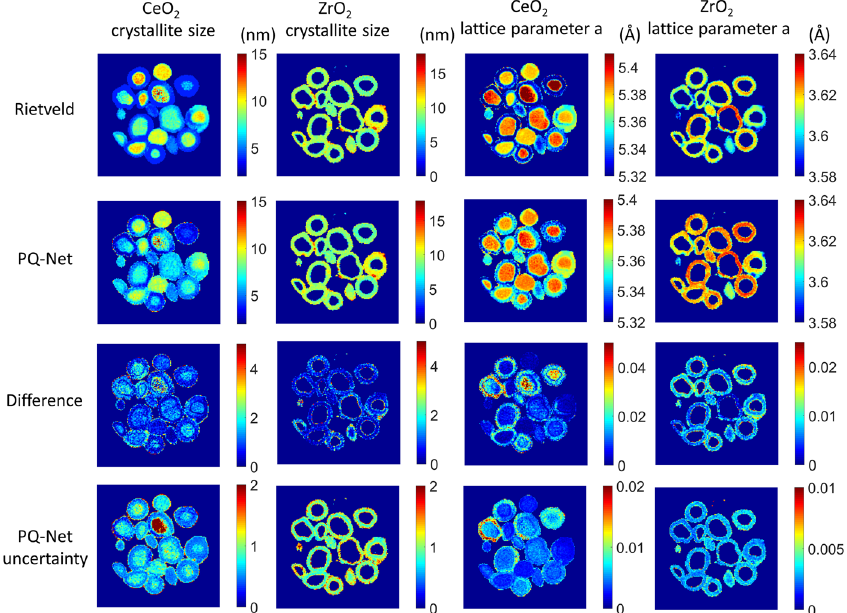
Fig. 6 PQ-Net CeO2-ZrO2 crystallite size and lattice parameter a results for the multi-phase experimental data. Crystallite size (colorbar axis corresponding to nm) and lattice parameter a (colorbar axis corresponding to Å ) maps for CeO 2 and ZrO 2 obtained with the Rietveld method, results obtained with the PQ-Net, their absolute difference for the experimental multi-phase NiO-PdO-CeO 2 -ZrO 2 -Al 2 O 3 system and the uncertainty maps of the deep ensemble